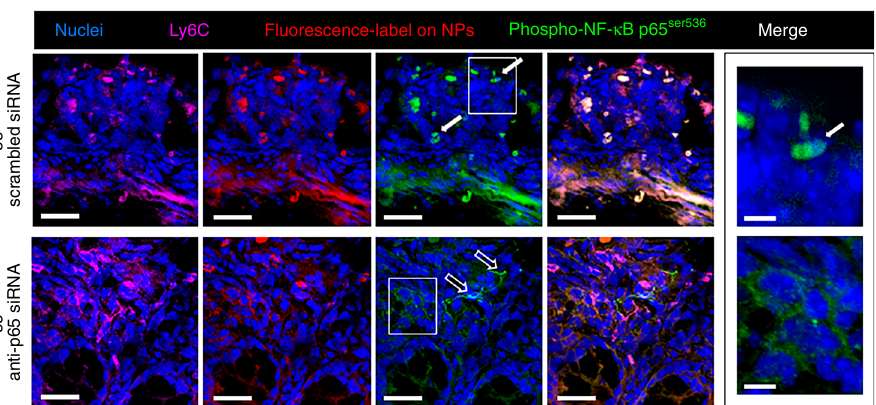
these cells by fl uorescence microscopy. Mice treated with control NPs showed nuclear translocation of phosphorylated NF- κ B p65 in their Ly6C + intestinal macrophages. In contrast, animals treated with anti-p65 NPs showed no p65 phosphorylation or nuclear translocation (Fig. 8d).